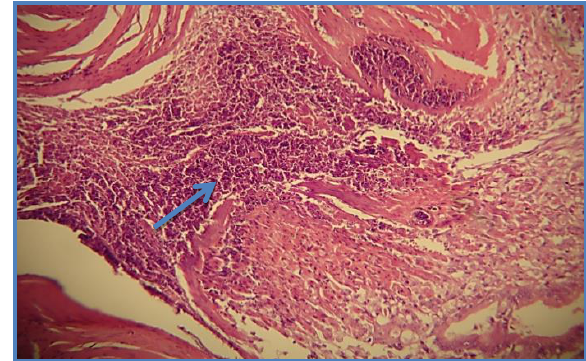
Figure, 5: Stomach of rabbit (G1), at 7th day p.o showing infiltration of large number of dead neutrophils in the subserosal and submucosal layers and in between the myofibers (blue arrow) (H and